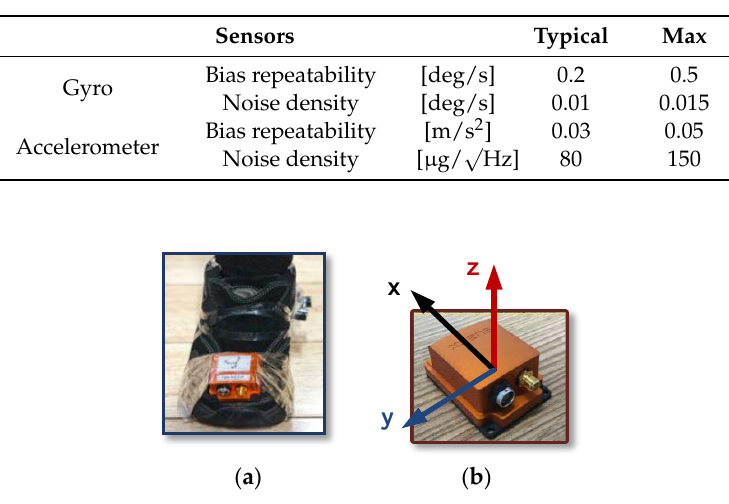
Figure 6. The position and the orientation of externally located MTI-710 on Shoe . ( a ) MTi-G710 installed on on the foot; ( b ) MTi-G710 and its the foot; ( b ) MTi-G710 and its frame.